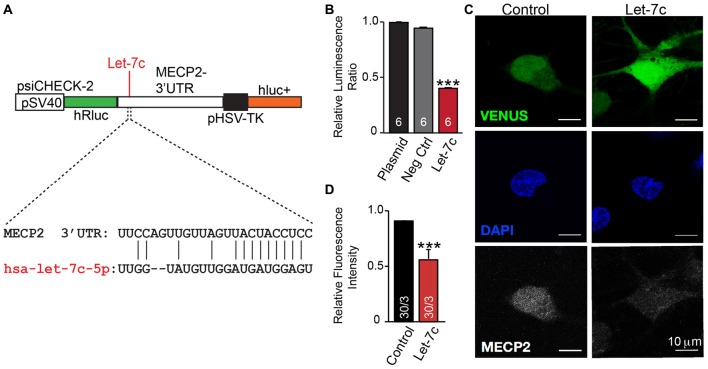
let-7c targets MECP2 3’ UTR and reduces MeCP2 protein levels in human induced neurons. (A) Schematic of the MECP2 3’UTR cloned into the psiCHECK-2 dual luciferase reporter, with indication of the putative hsa-let-7c binding site present within this sequence. (B) let-7c, but not control overexpression miRNA or empty vector, significantly reduces normalized Renilla luminescence compared to controls, suggesting that it is capable of binding to the MECP2 3’UTR. (C,D) Overexpression of hsa-let-7c in human iN cells results in a reduction in the relative fluorescence intensity of MeCP2 as determined by immunohistochemistry. ***p < 0.001.